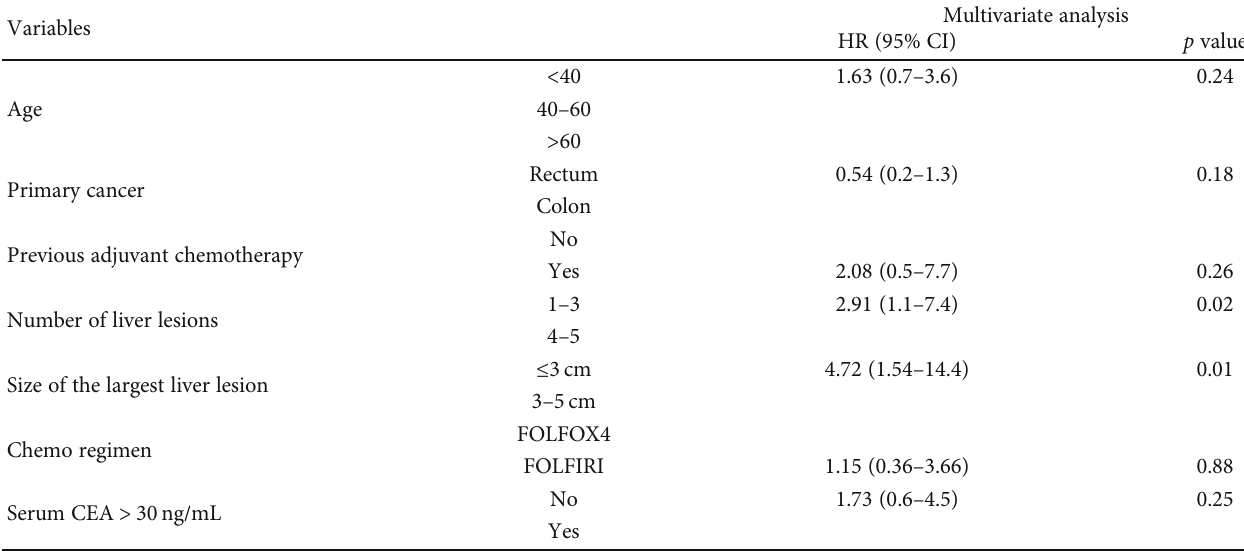
Table 3: Multivariate analysis of independent prognostic factors for overall